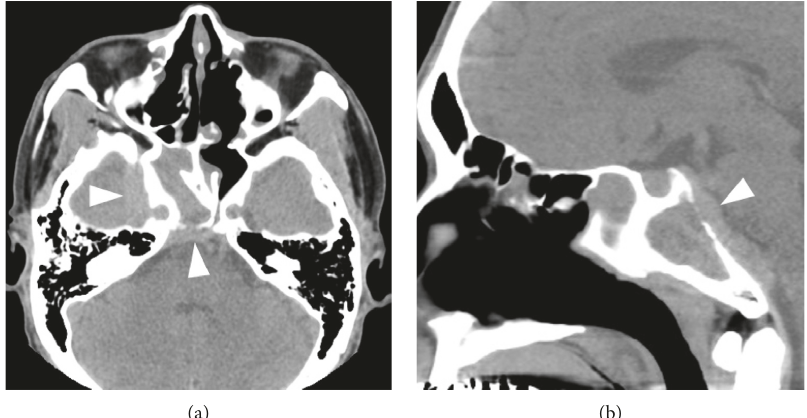
Figure 4: CTscan 18 months after being diagnosed with GPA shows a lesion of the right sphenoid sinus eroding the bone of the clivus and thickening of the dura mater on axial (a) and sagittal (b) images